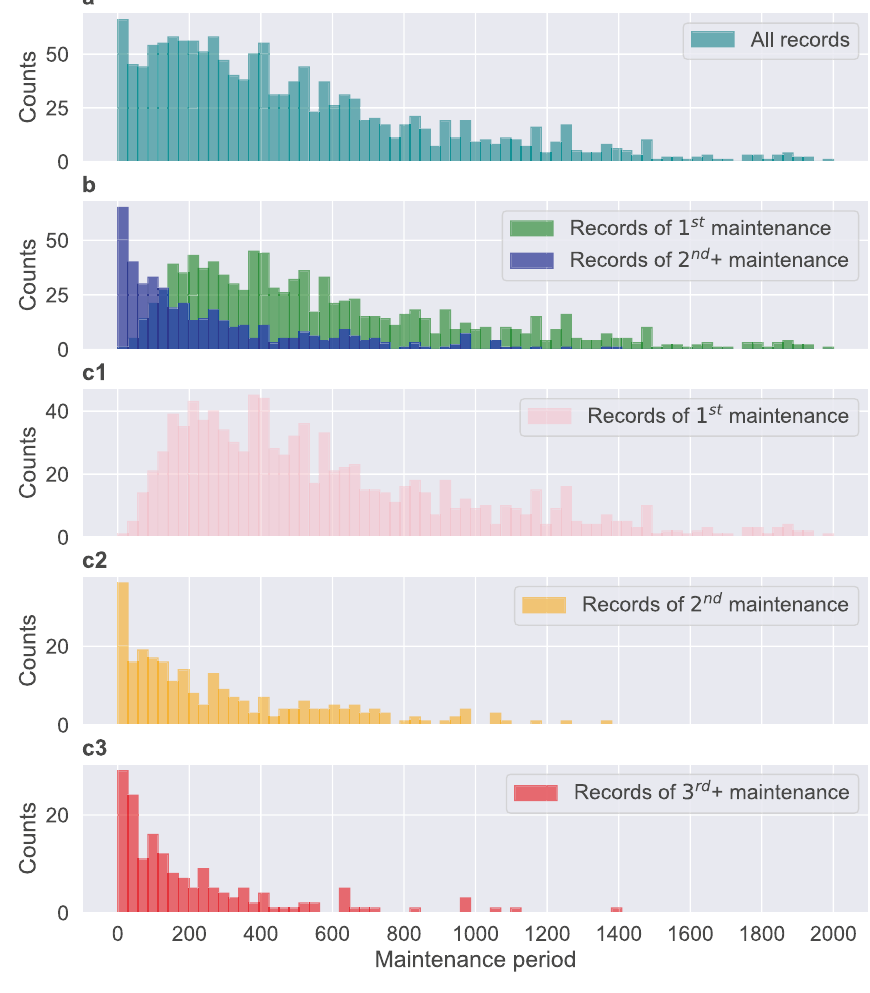
Figure 4. Histograms of maintenance periods for different record types. A : Distribution for all (uncensored) records (1, 387 records). B : Subdivision of the distribution in A into two types of records. The components of the 1st maintenance are shown in blue (987 records) and the components of the 2nd + maintenance in green (400 records.). C1–C3: A comparison between different replacement periods of records of 1st maintenance (C1), 2nd maintenance (C2) and 3rd + maintenance (C3), corresponding to 987, 252, 148 records